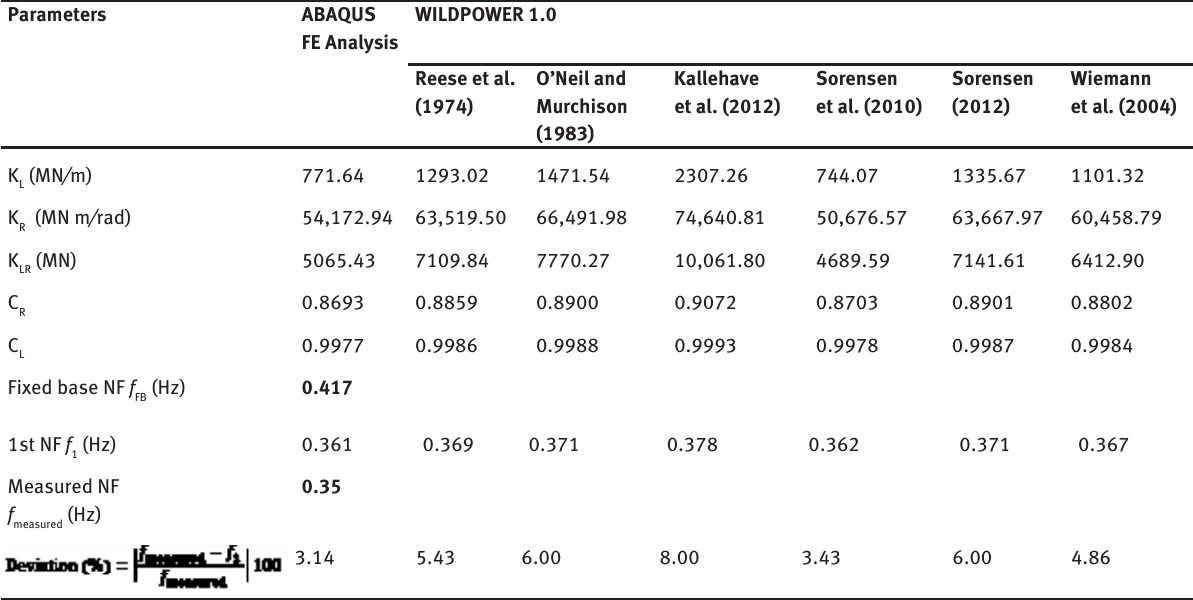
Table 7: Stiffness coefficients, interaction factors, and the different 1st NFs computed for the OWT at North Hoyle.